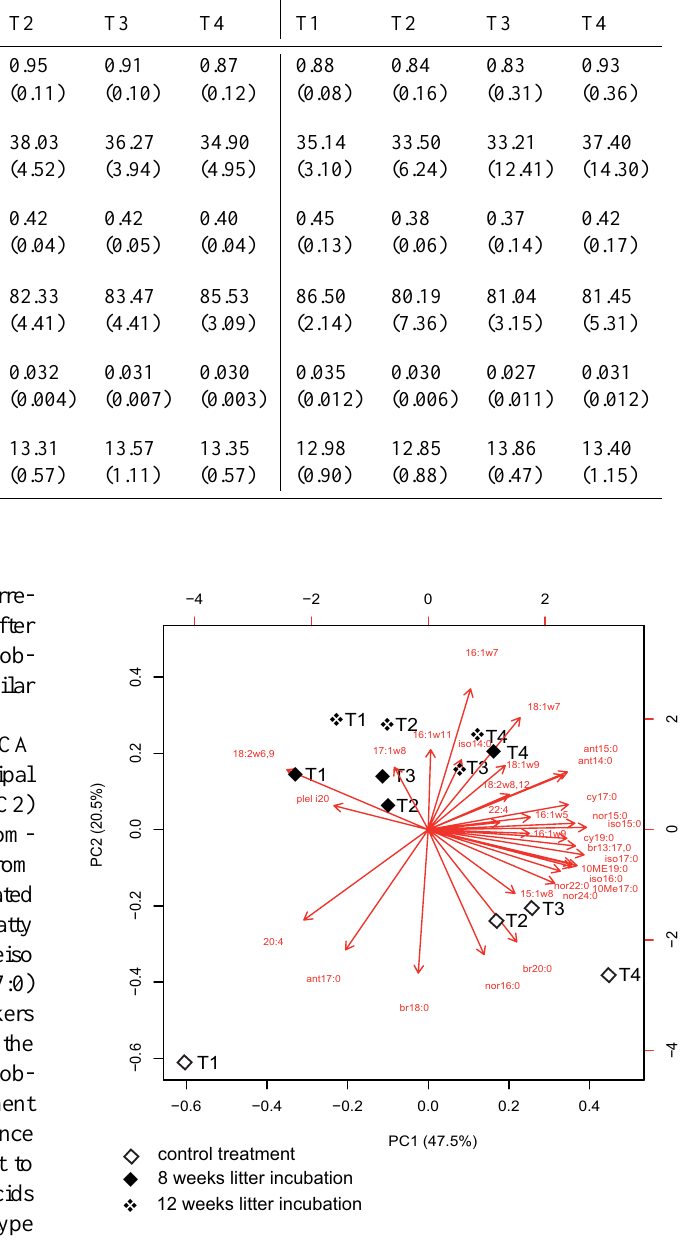
plant litter (g per litterbag DW)